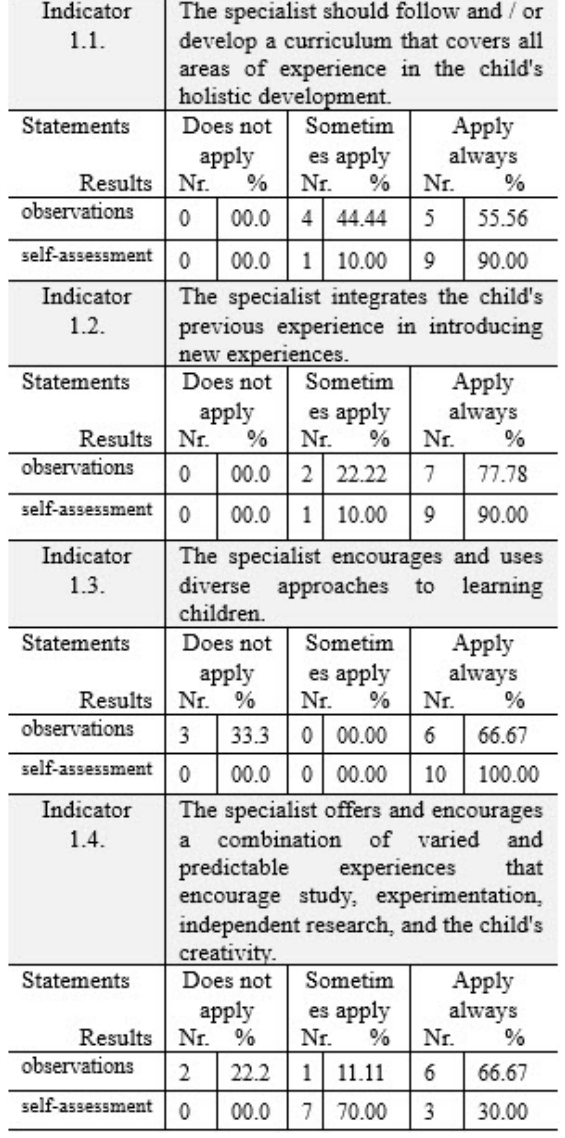
Table 18. Principle 1: The development of children is holistically approached.